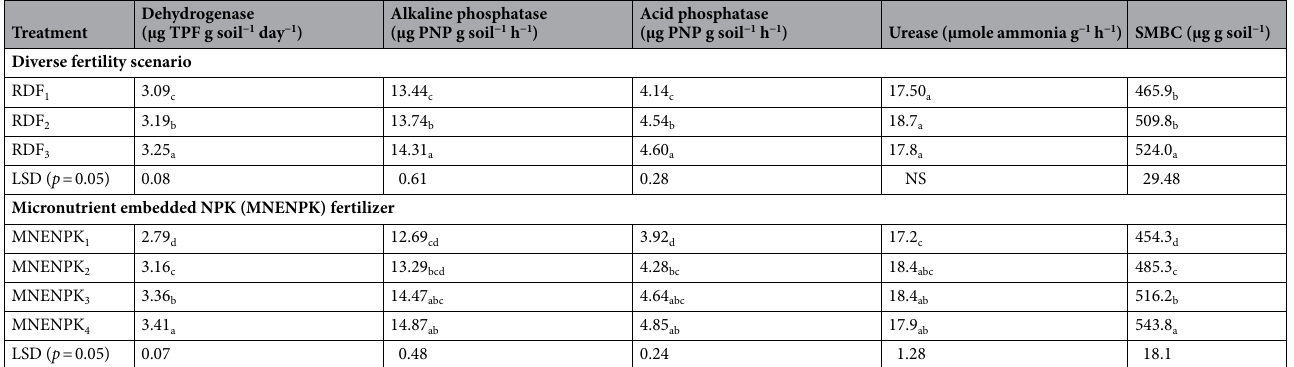
Table 2. Effect of diverse fertility scenarios and multi-micronutrient foliar fertilization on soil microbial activities of eggplant. Means followed by a similar lowercase letter within a column are not significantly different at p < 0.05 according to Tukey’s HSD test; data are pooled means of 2017–2018 and 2018–2019 cropping seasons. SMBC soil microbial biomass carbon.